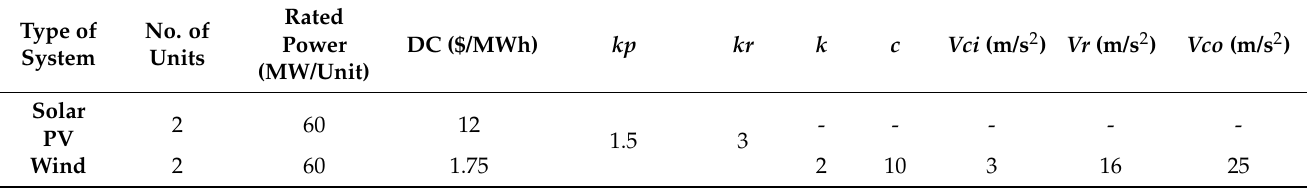
Table A2. Data for Solar PV units and wind